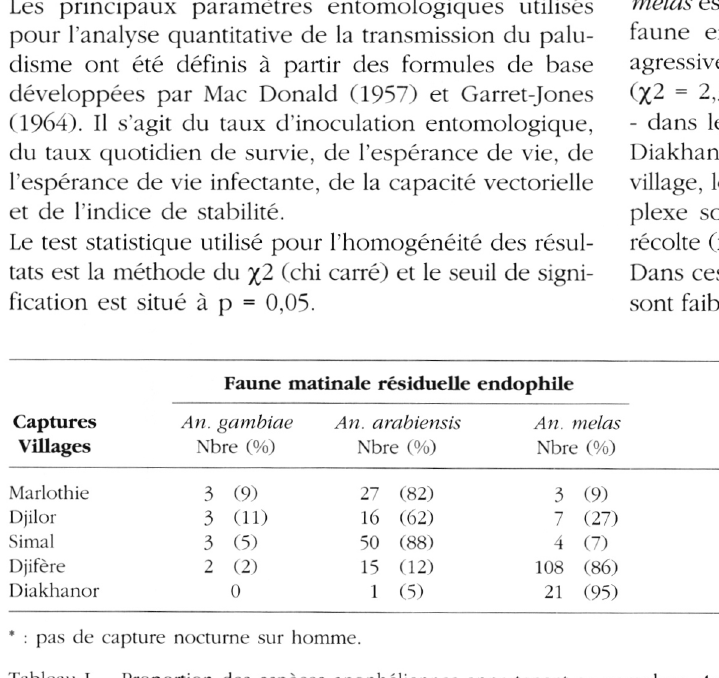
Tableau I. - Proportion des espèces anophéliennes appartenant au complexe An. gambiae selon les localités.